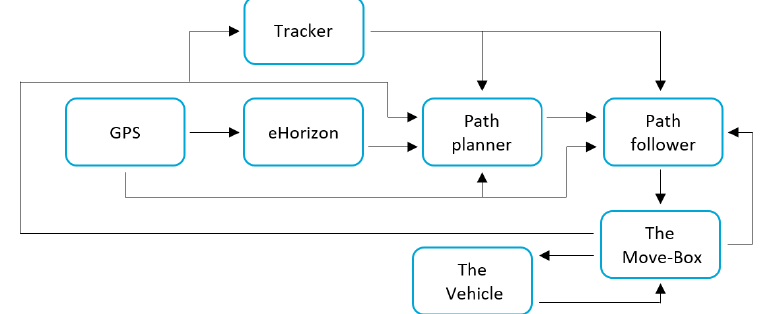
Figure 2. Schematic view of the autonomous vehicle